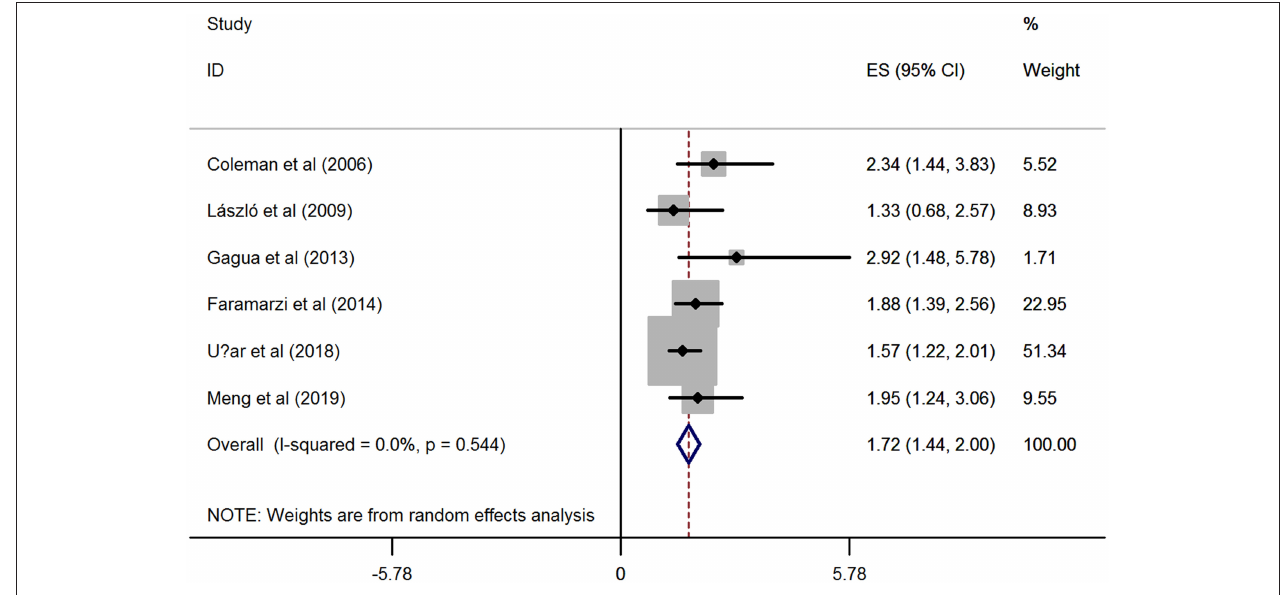
FIGURE 2 | Forest plots of meta-analysis based on six eligible studies providing the cases of